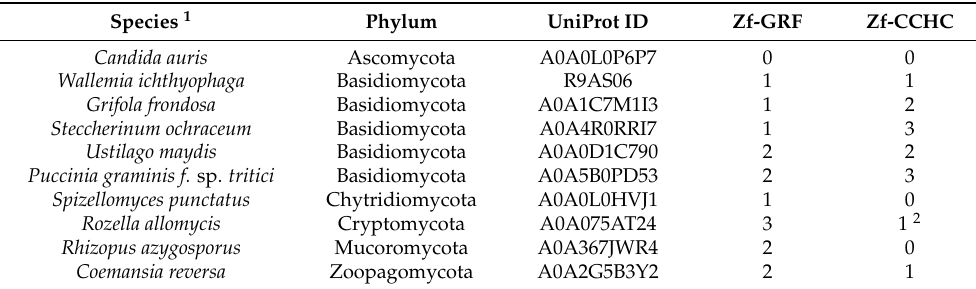
Table 3. Examples of species with the different combinations of repeated units of zf-GRF and zf-CCHC observed in fungal topoisomerase III. Numbers of zf-GRF and zf-CCHC found in this individual topoisomerase III (Top3) are shown